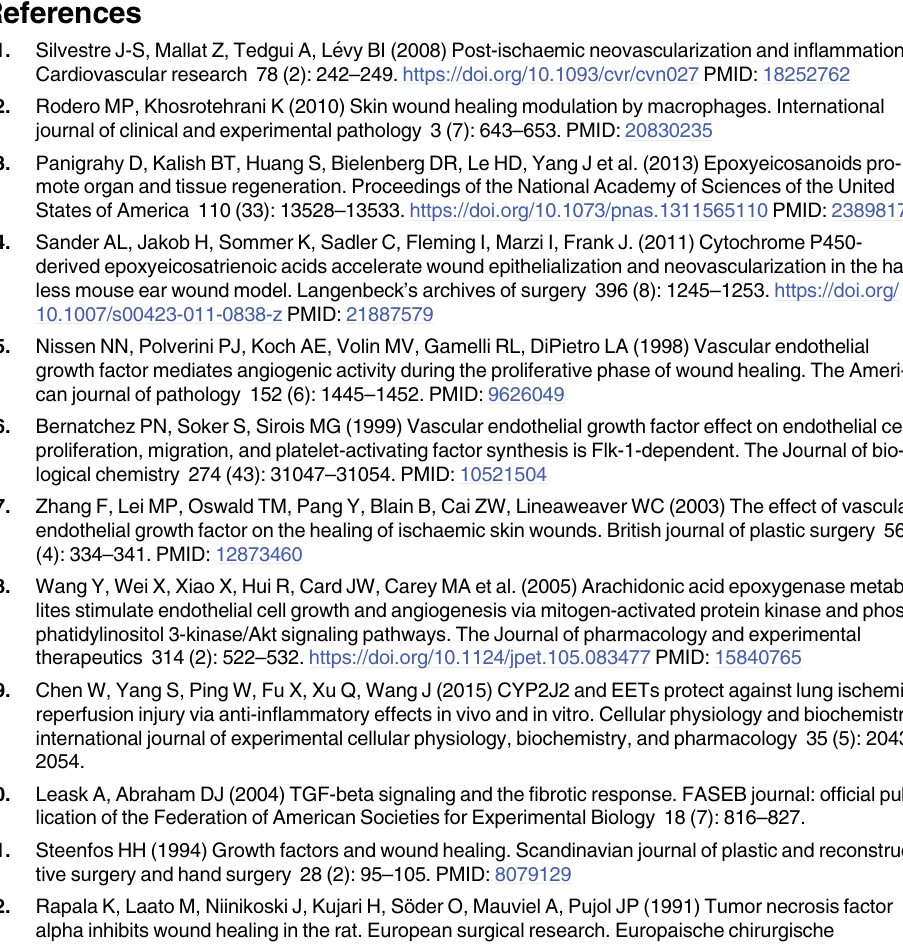
S9 Table. Raw data of percentage of SDF-1 α positive area on day 3, 6 and 9 after wounding of control, ischemic and 11,12 as well as 14,15 EET treated ischemic